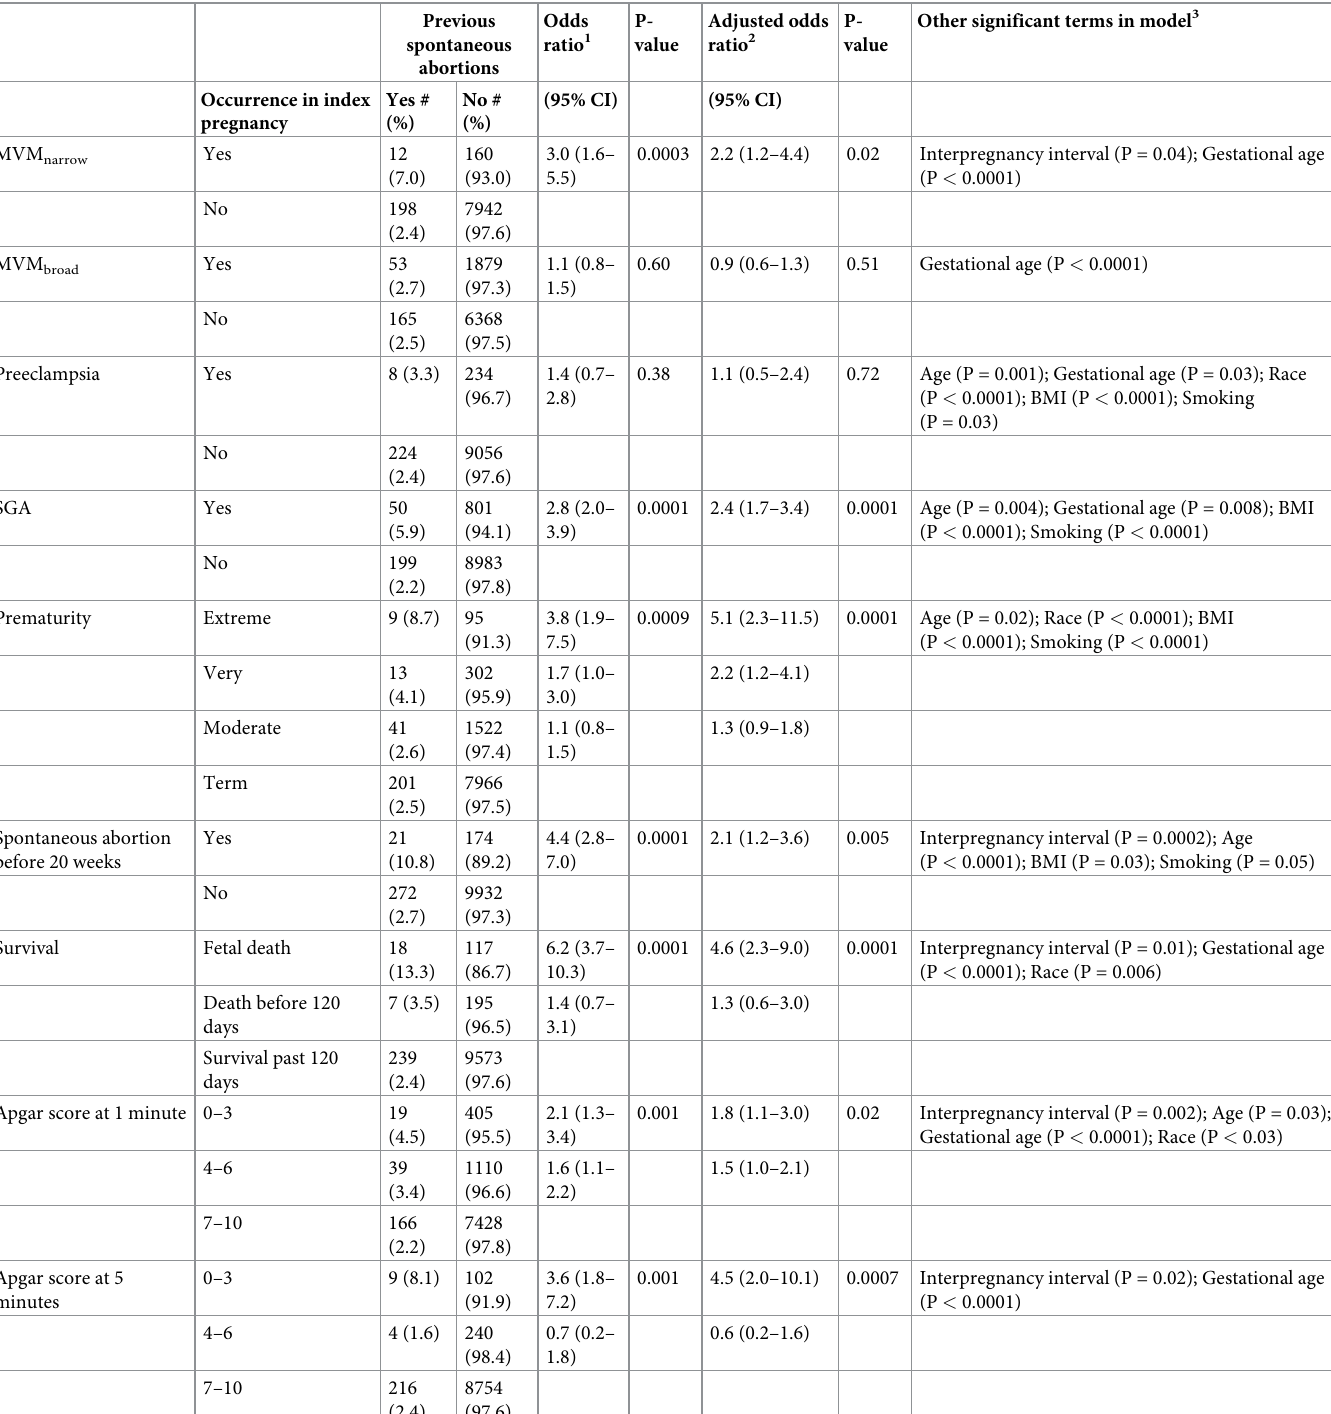
Table 3. Associations between previous spontaneous abortions and pregnancy